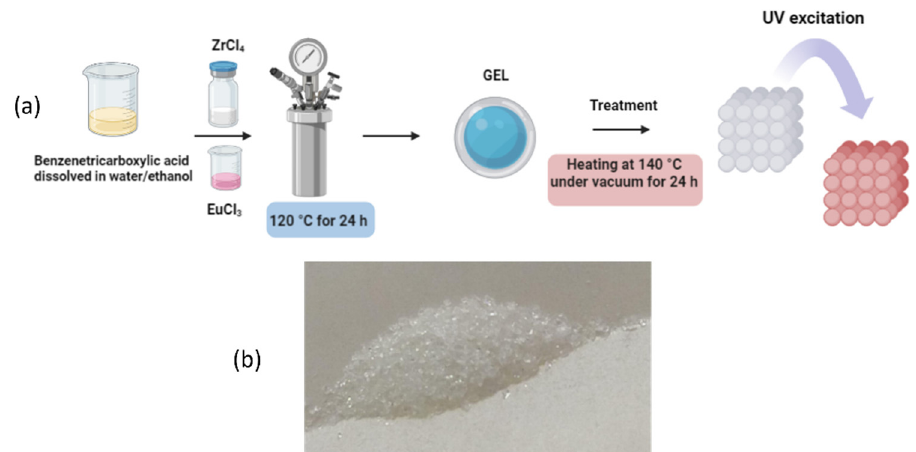
Figure 1. ( a ) Schematical illustration of the synthesis procedure; ( b )The digital images of the amorphous [(Eu 2 Zr)(btc) 3 (Hbtc) 0 . 5 ·6H 2 O)] coordination compound.